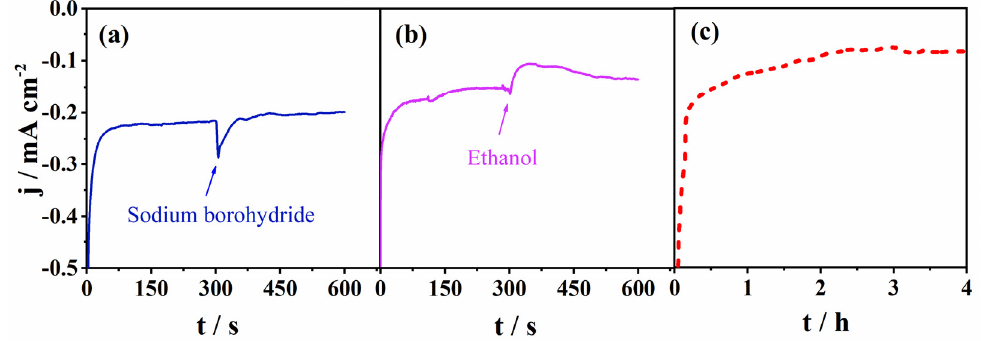
Figure 5. Chronoamperometric responses of Mn-CP in O 2 -saturated 0.1 M KOH at a potential of 0.56 V. ( a ) With the addition of 5 mg of sodium borohydride; ( b ) with the addition of 3 M ethanol in the 300th s; ( c ) stability test during 4 h.